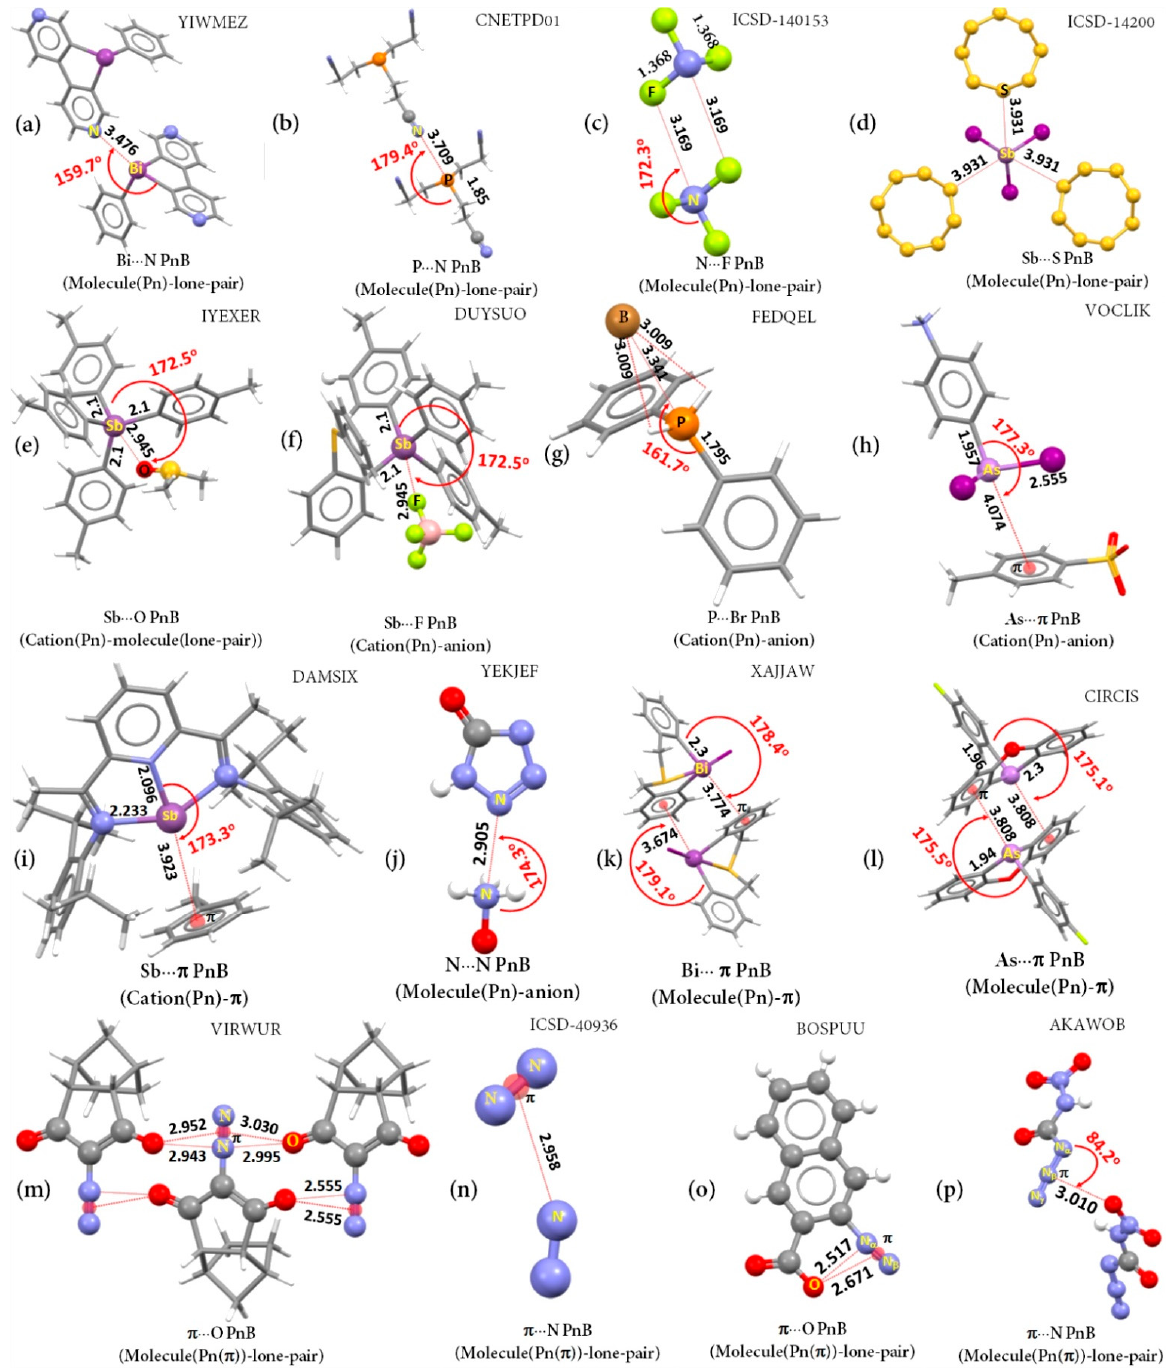
Figure 2. Some selected solid-state systems featuring pnictogen bonding: ( a ) 9-phenyl-9H-bismolo [2,3-c:5,4-c’]dipyridine [100]; ( b ) 3 ′ ,3 ′ ’,3 ′ ’’-Phosphinetriyltripropionitrile [101]; ( c ) trifluoroamine [102]; ( d ) antimony triiodide molecular sulfur S8 [103]; ( e ) bis(tetrakis(4-methylphenyl)-antimony) hexabromo-iridium [104]; ( f ) tris(4-methylphenyl)-(2-(phenylsulfanyl)phenyl)-antimony tetra- fluoroborate [42]; ( g ) diphenylphosphenium bromide [105]; ( h ) 4-(di-iodoarsino)anilinium 4- methylbenzenesulfonate [106]; ( i ); (1,1 ′ -(pyridine-2,6-diyl)bis[N-[2,6-di-isopropylphenyl]ethan-1- imine])-antimony [107] ( j ) 5-oxo-4,5-dihydrotetrazol-1-ide azane oxide [40]; ( k ) (2,2 ′ -[sul-